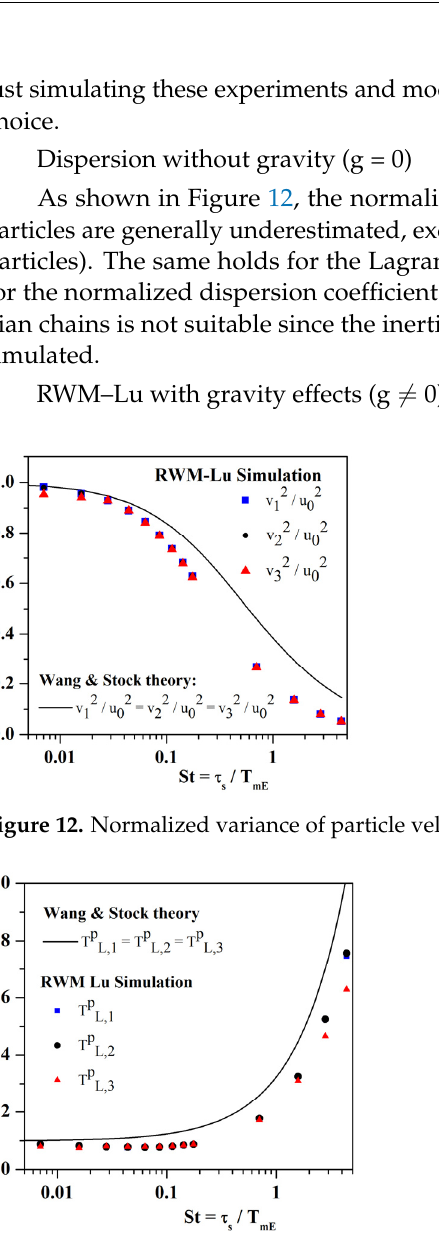
Figure 13. Particle Lagrangian time scale (g = 0).